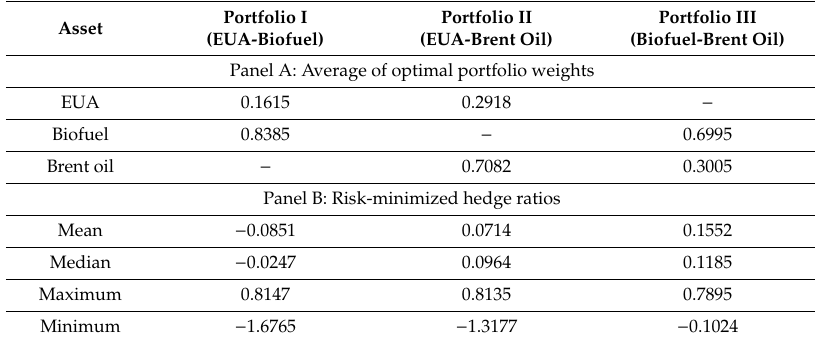
Table 8. Optimal portfolio weights and hedge ratios for the EUA, biofuel and Brent oil markets using the model with the sudden change